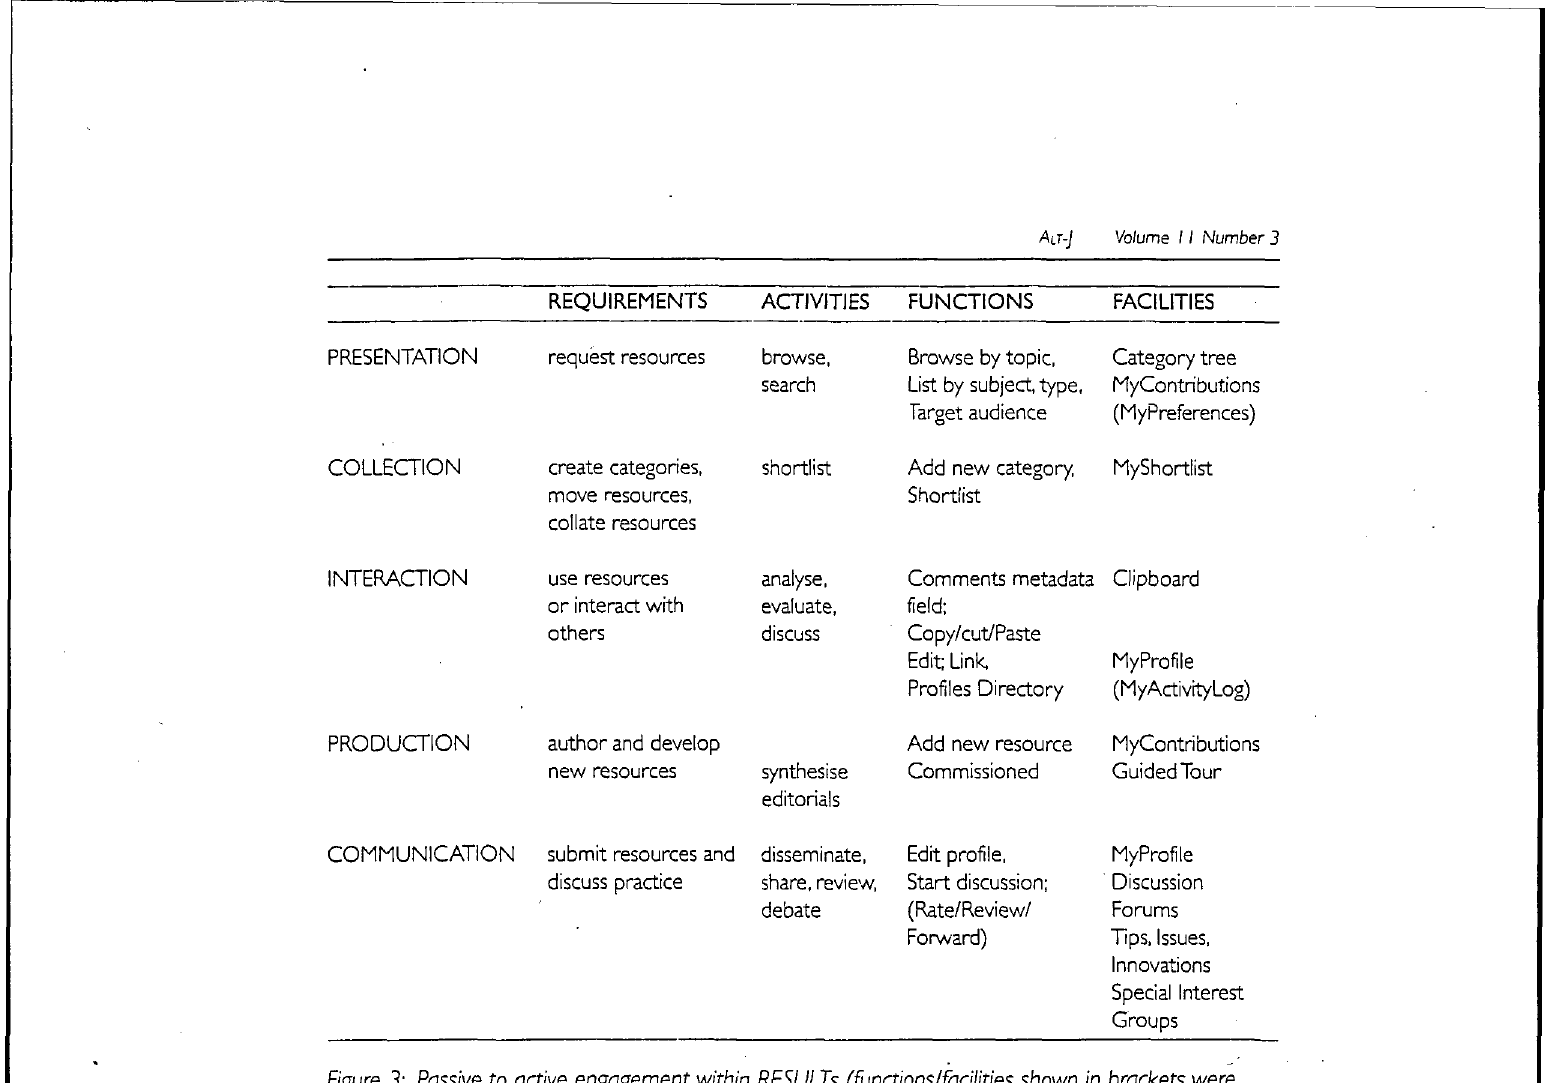
Figure 3: Passive to active engagement within RESULTs (functions/facilities shown in brackets were those that could not be implemented within the project timescale, but which the system can support